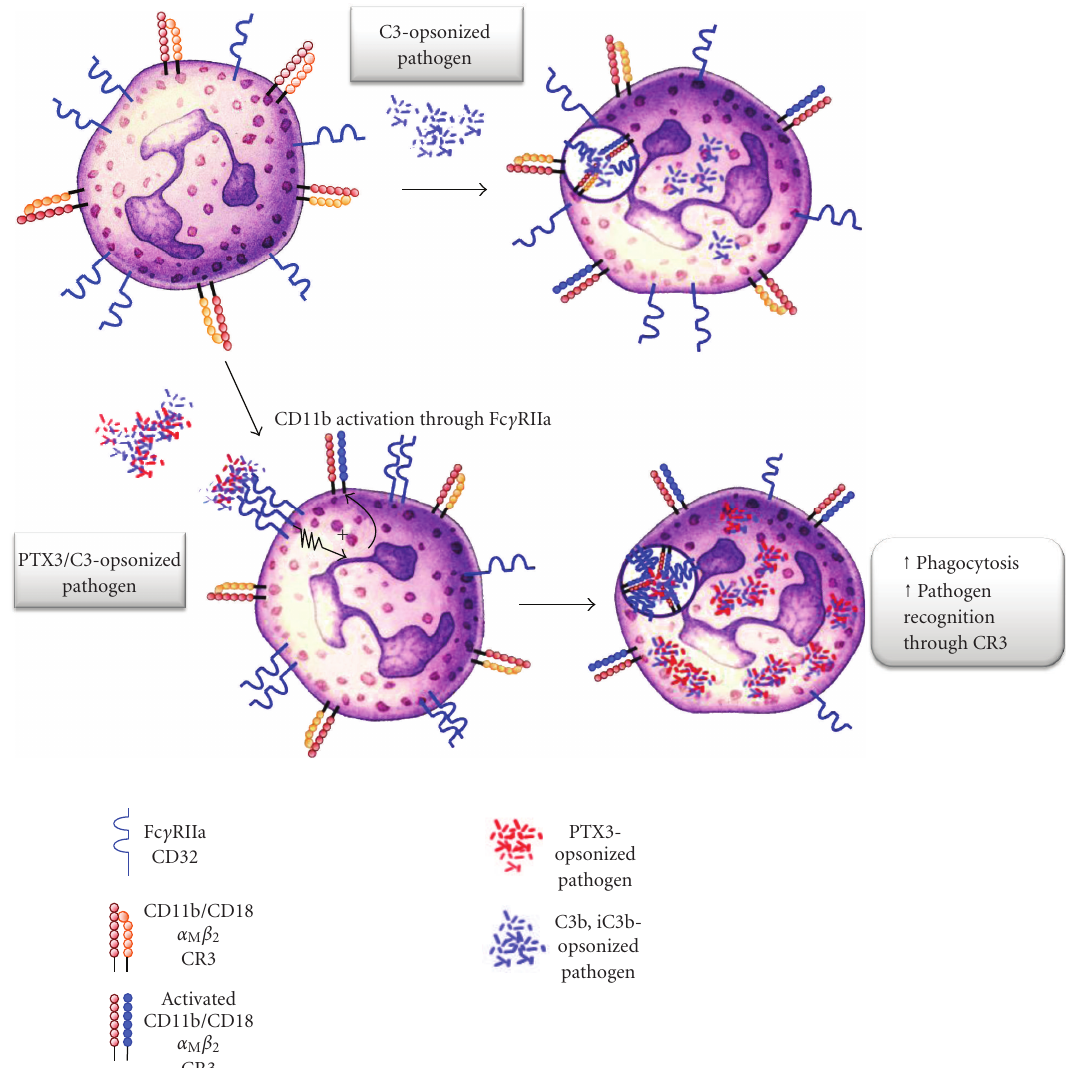
Figure 3: Model of the PTX3-dependent opsonisationof A. fumigatus conidia. In the presence of PTX3-opsonized conidia, Fc γ RIIA induces inside-out CD11b/CD18 activation, recruitment to the phagocytic cup, and amplification of C3b-opsonized conidia phagocytosis.